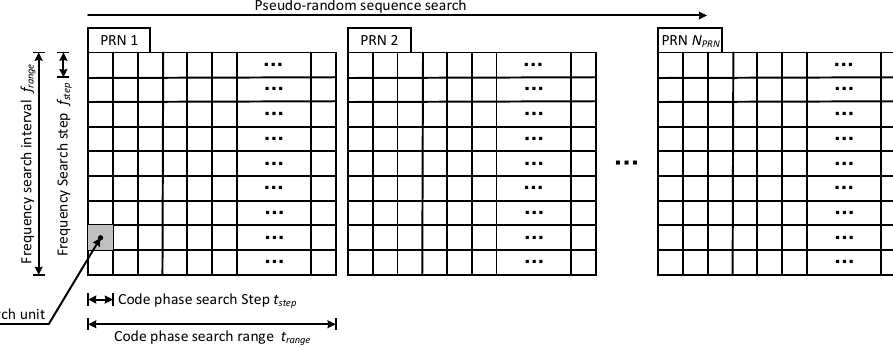
search units. The